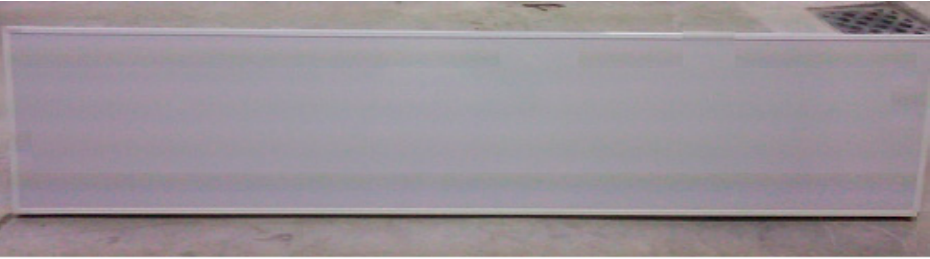
Figure 5. Rigid member (PVC): length 1.9 m; density 181.05 (kg/m 3 ); weight 8.6 kg, thickness 0.02 m. Table 1. Properties of elastic plates and generated waves.